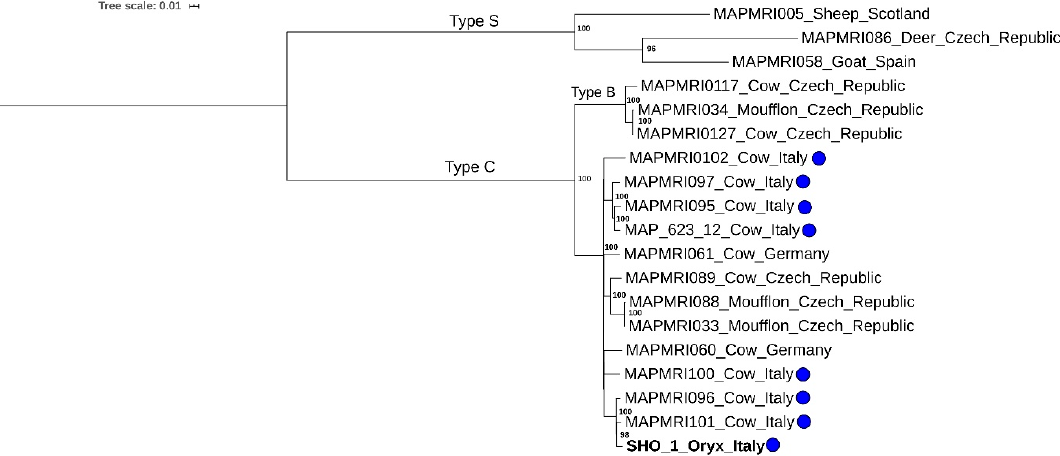
Figure 3. Maximum likelihood phylogenetic tree of MAP isolates selected for this study. Oryx isolate is indicated in bold type, and Italian isolates are indicated with a blue circle. Bootstrap values are reported on the right side of the nodes.